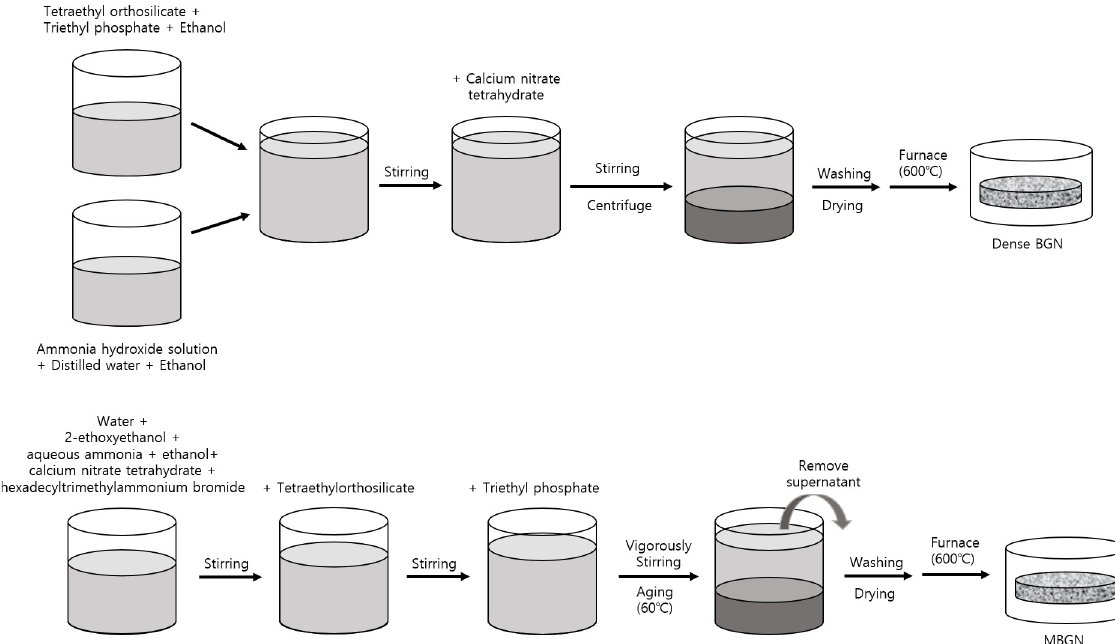
Fig 2. An experimental visual form of bioactive glass nanoparticle by sol-gel method. (a) Dense BGN, (b)